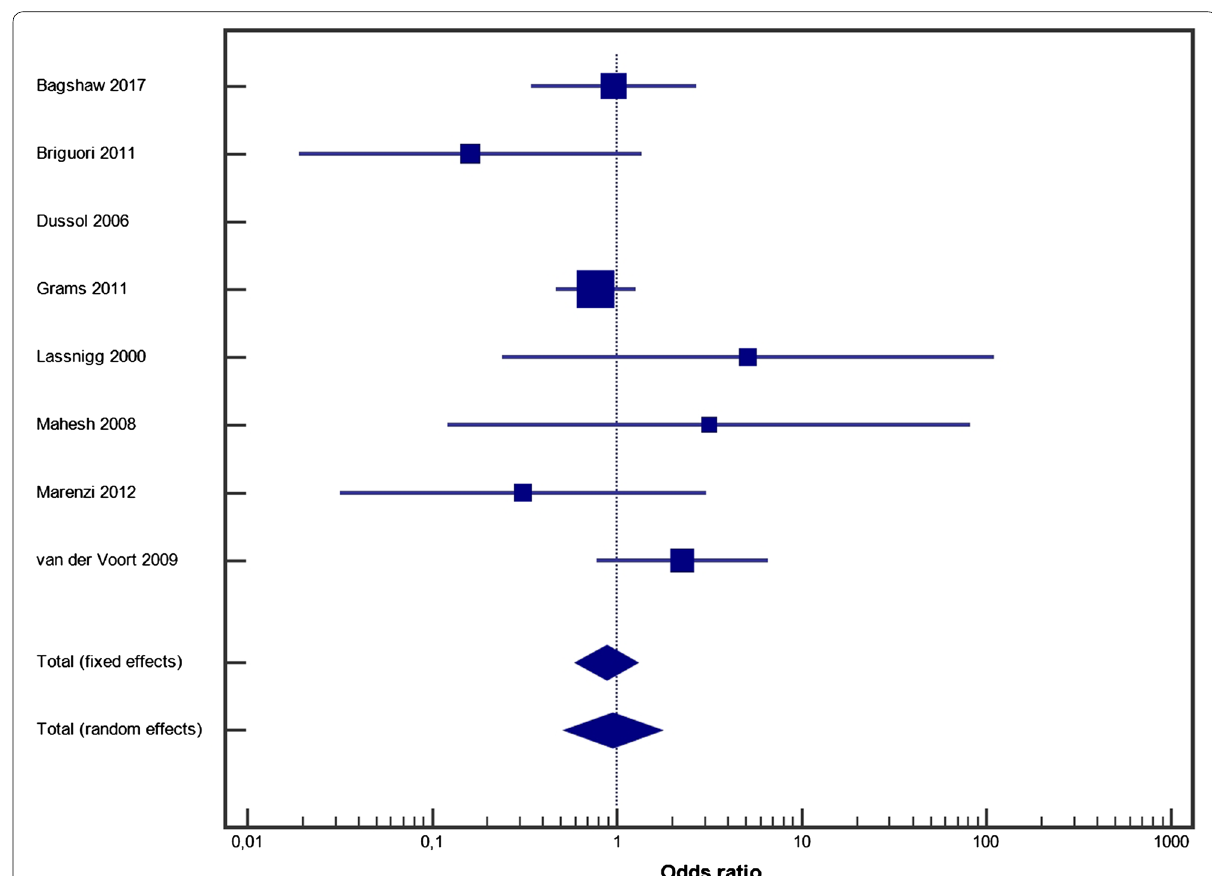
Fig. 3 Forest plot for furosemide use and the requirement for renal replacement